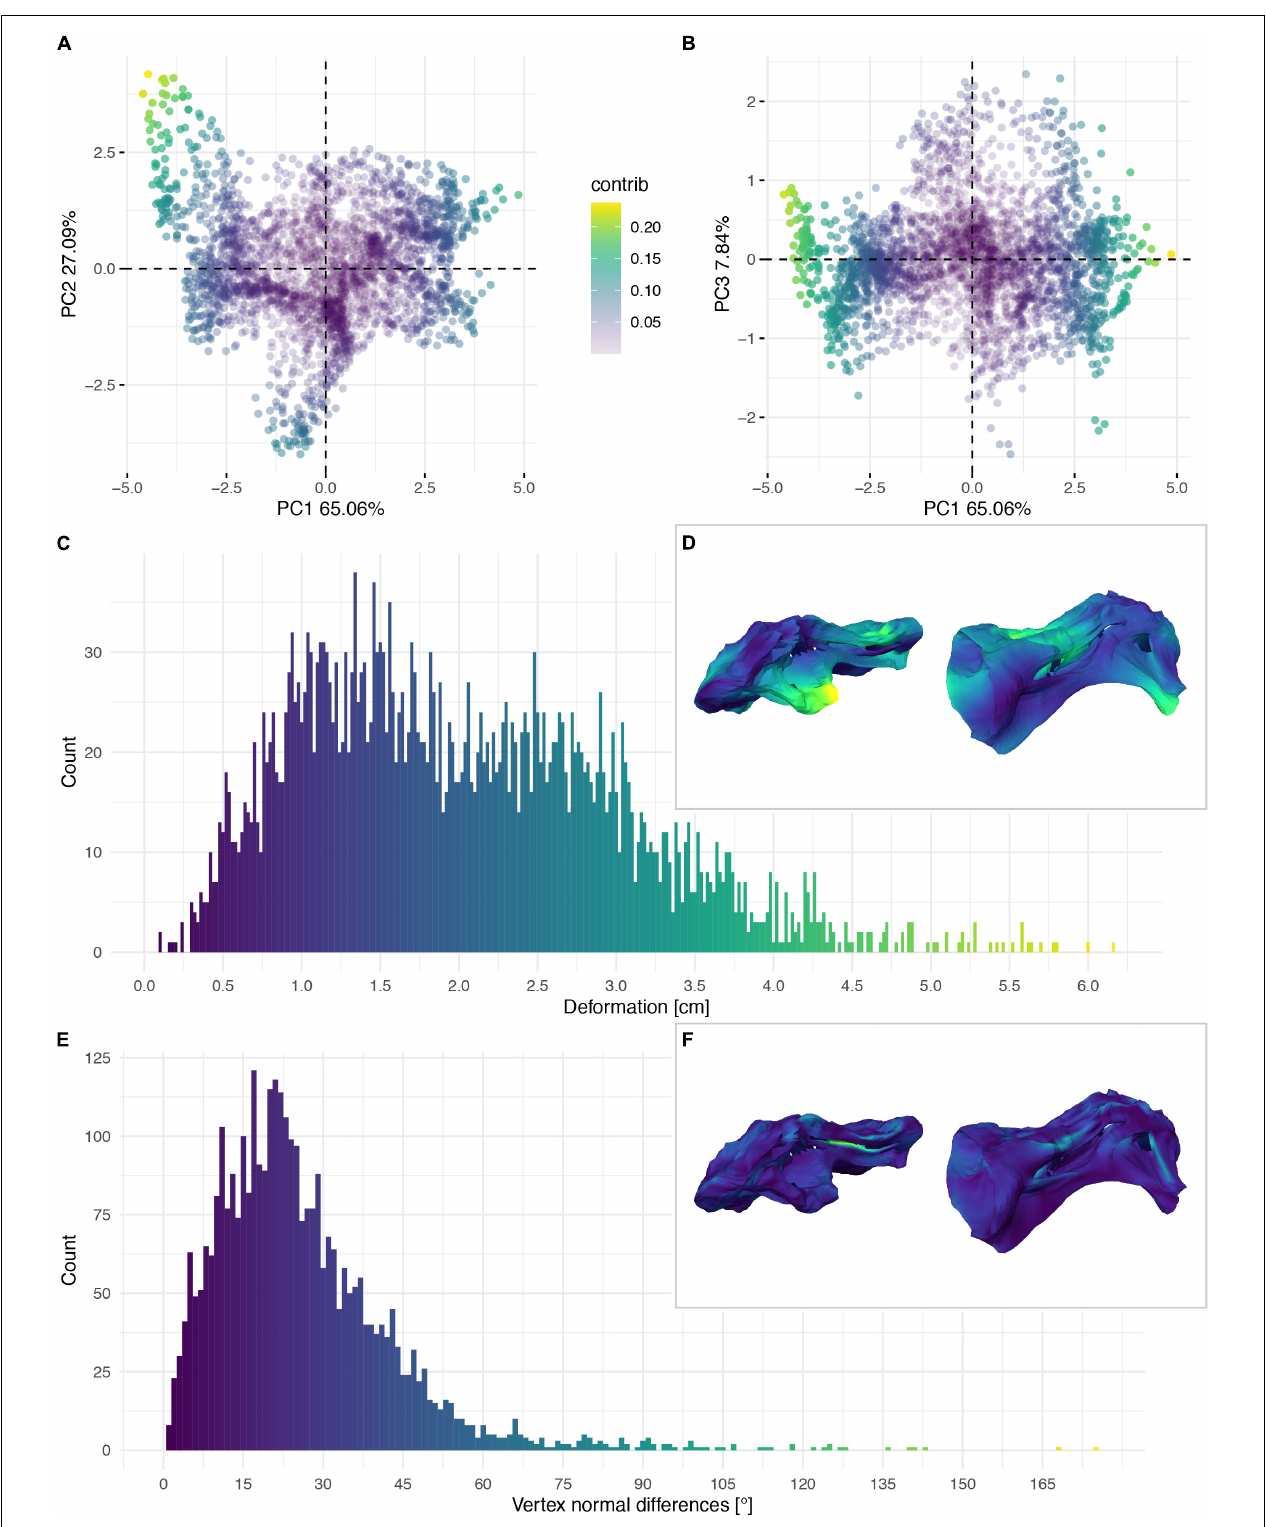
FIGURE 7 | Deformation of the vertebral centrum of CV 8 of Galeamopus pabsti SMA 0011/NMZ 1000011. PCA of the differences in the components of the vector between corresponding vertices (A,B) . PC1 represents the major axis of deformation. Histograms of the absolute deformation (morphological distance) between the reconstruction and the original specimen (C) and the angles between the different orientations of the corresponding vertex normals (E) . Visualisation of the deformations in oblique views (D,F) .